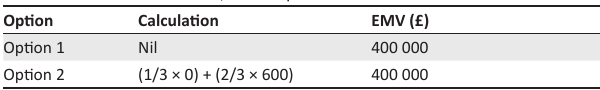
TABLE 4: EMV for Initiative A, when options are in terms of